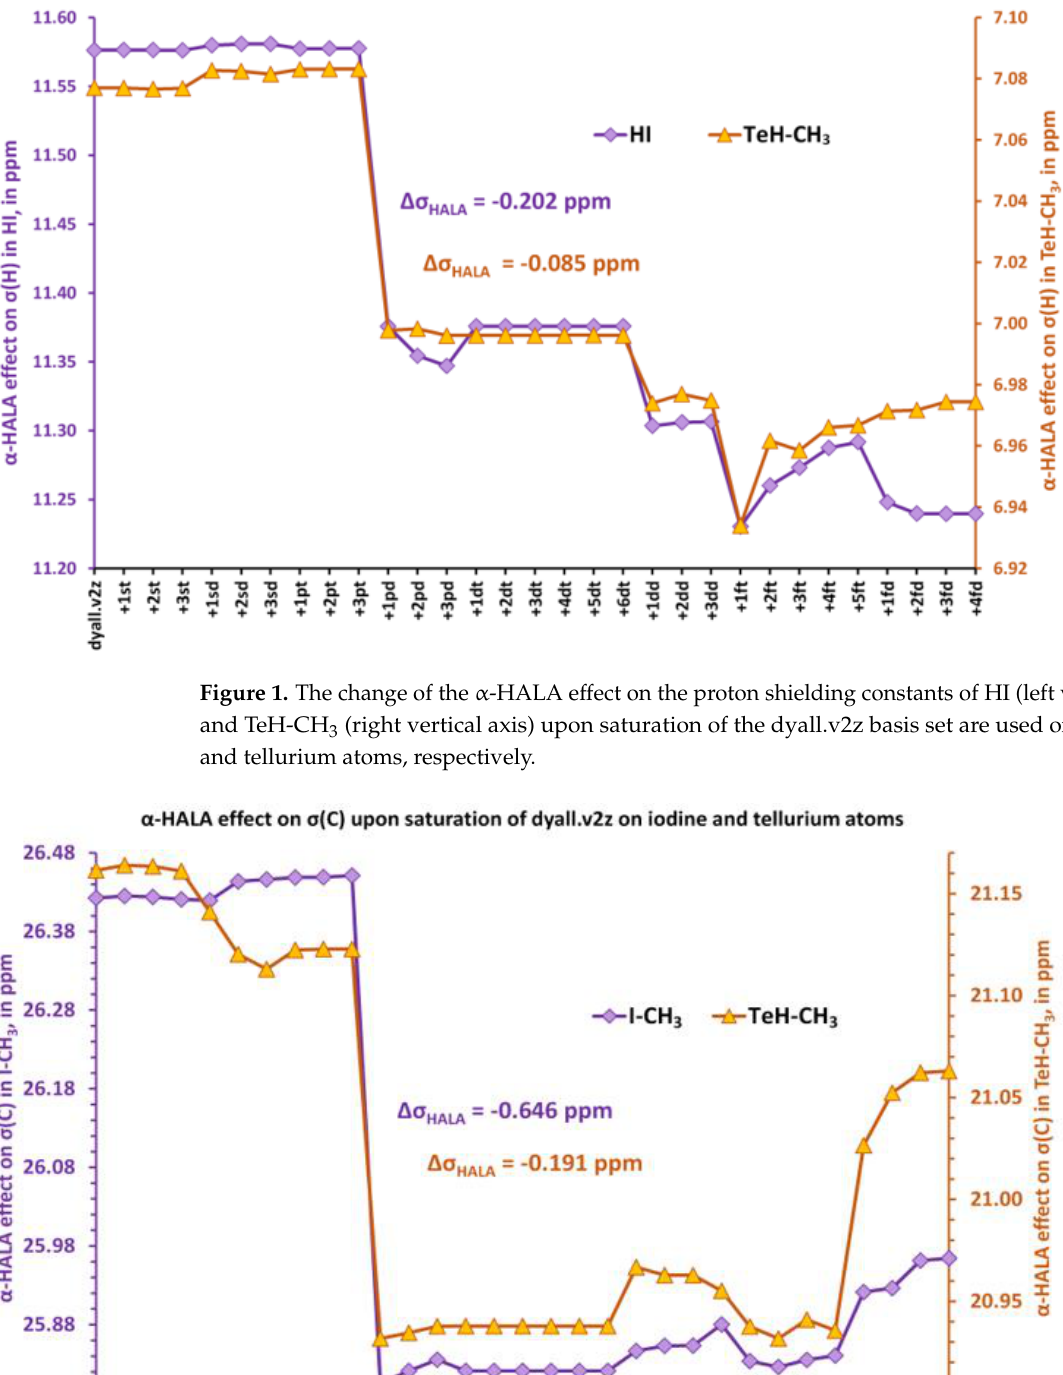
tions of k -type ( k = s , p , d , …) to the previous basis set, with l designating a particular region